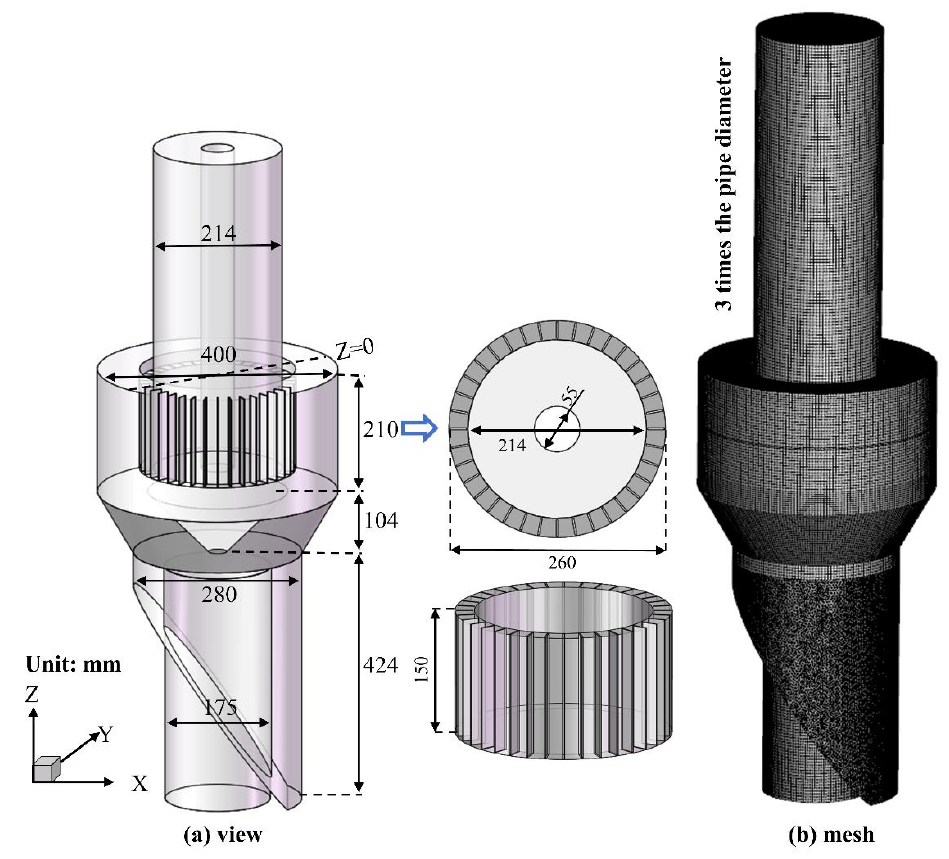
Figure 3. High-efficiency rotor classifier structural dimensions and the CFD mesh.